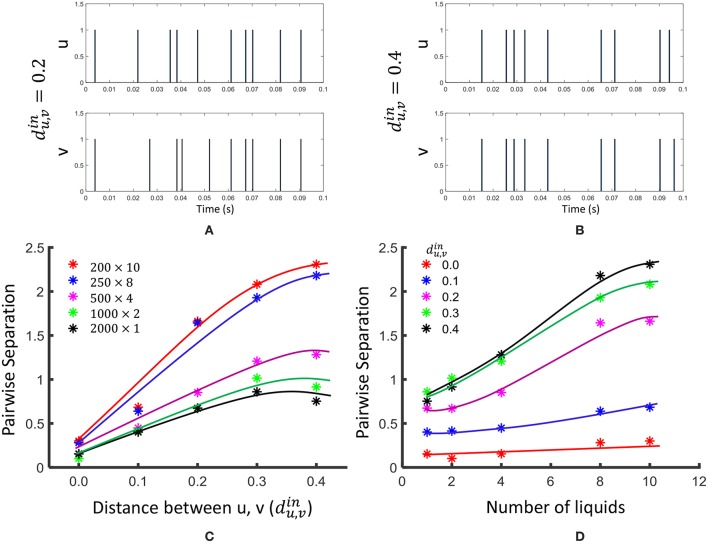
The effect of dividing a large liquid on SPpw, at different distances du,vin between inputs. Two input spike trains u and v are illustrated at (A)
du,vin and (B)
du,vin. (C) The variation of pairwise separation with the distances between inputs, at different number of liquids (D) The variation of pairwise separation with the number of liquids, at different input distances du,vin.